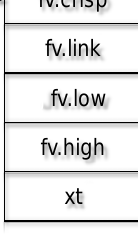
Figure 2. The definition of a fuzzy variable include a new entry in the Flash memory word dictionary and allocates five contiguous cells in RAM as a sequence of fields. The first cell stores the crisp input value, while the link field contains the address of the first defined membership function related to the fuzzy variable. The following two cells store the validity range, while the last one stores the execution token ( xt ), i.e. the address of the word to sense the physical quantity associated with the fuzzy variable. Once the fuzzy variable name is used, the address of the first field is fetched on top of stack.